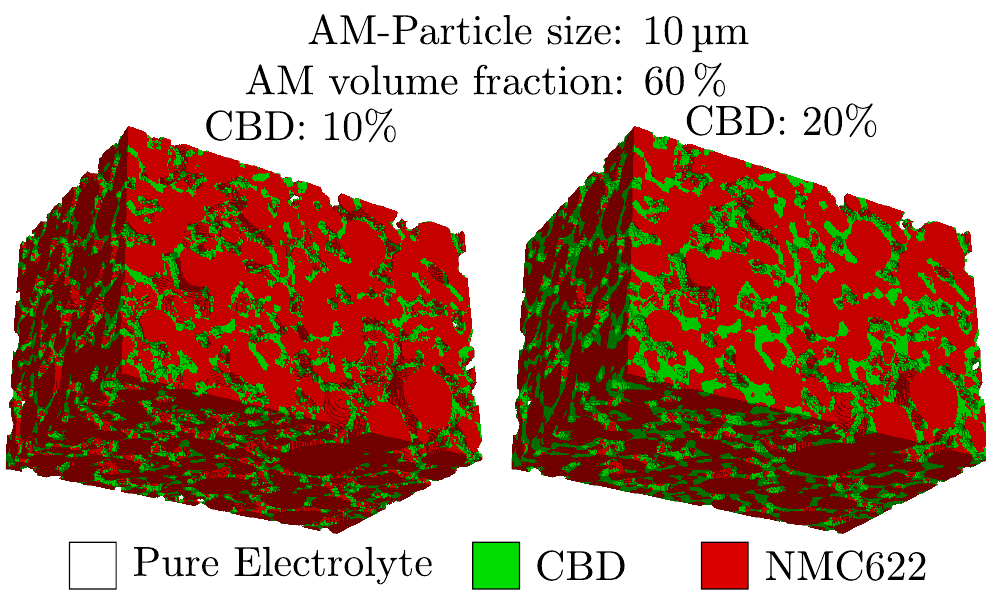
Figure 1. The spatial distribution of CBD for two different target volume fractions of